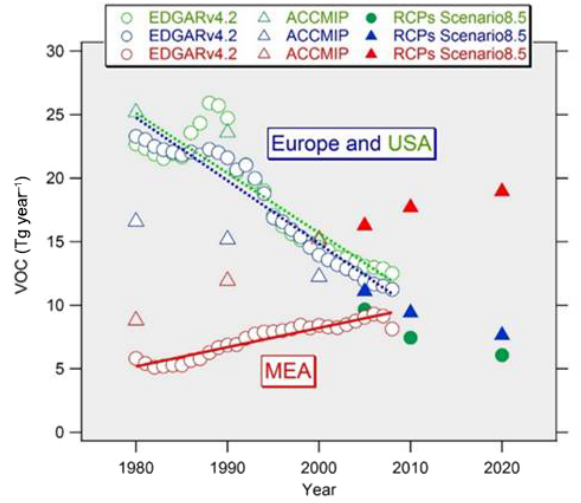
Figure 1. Evolution of the NMVOC anthropogenic total emissions (Tgyear − 1 ) in the MEA, USA, and Europe (OECD (Organisation for Economic Co-operation and Development) Europe and eastern Europe) from 1980 to 2020 from reference global emission inven- tories (ECCAD